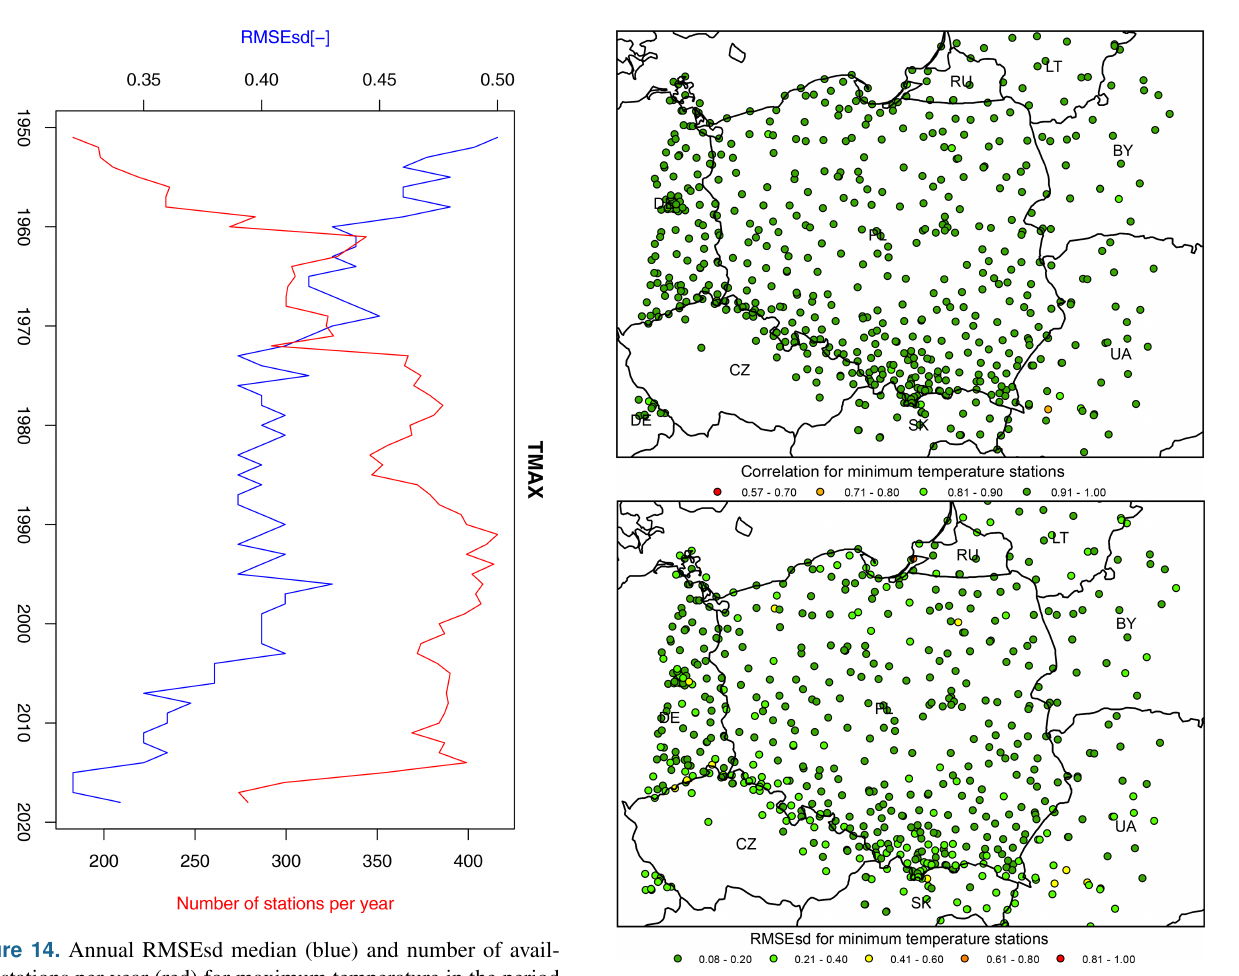
Figure 15. Minimum temperature ρ (top) and RMSEsd (bottom) values calculated for stations in the period 1951–2019. National borders (black lines) are labelled with country